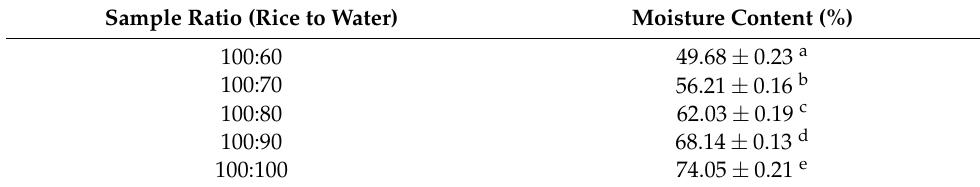
Means ± SD with superscript letters (a, b, c, d, and e) are significantly different at p <